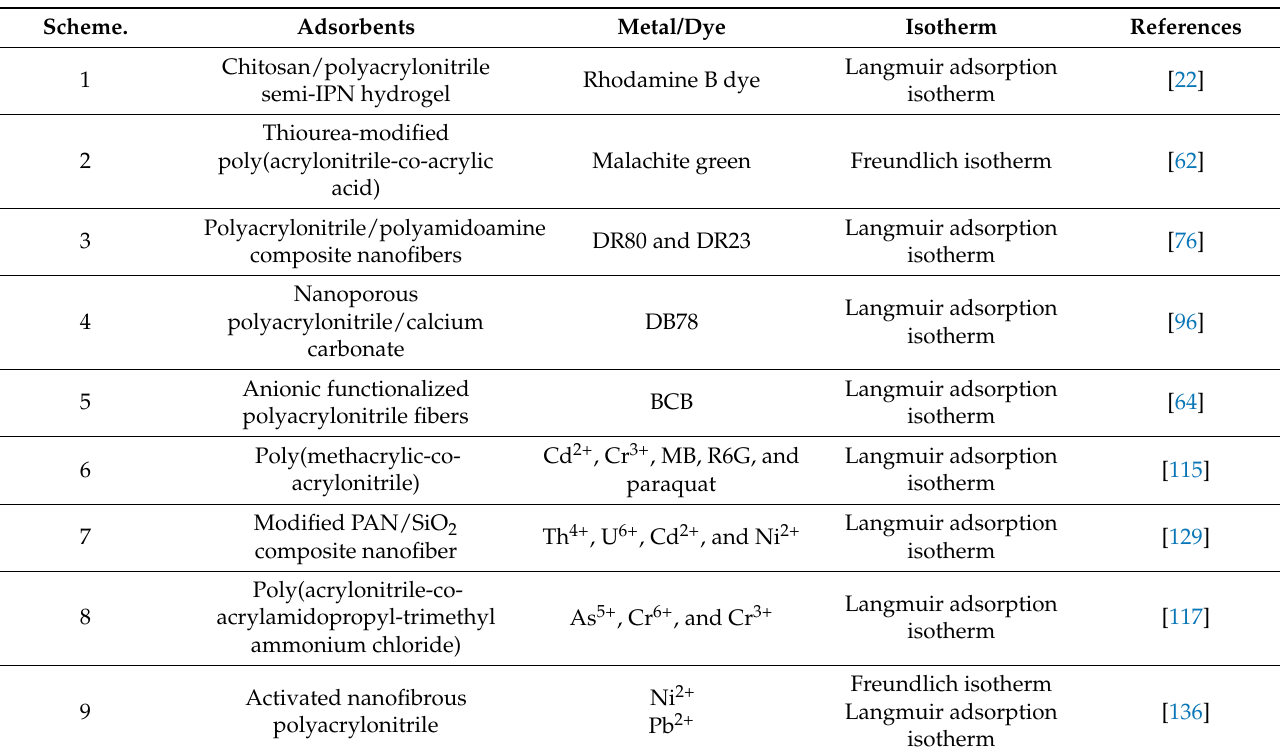
Table 2. Various adsorption isotherm models of the metal ion and dye sorption on modified poly- acrylonitrile